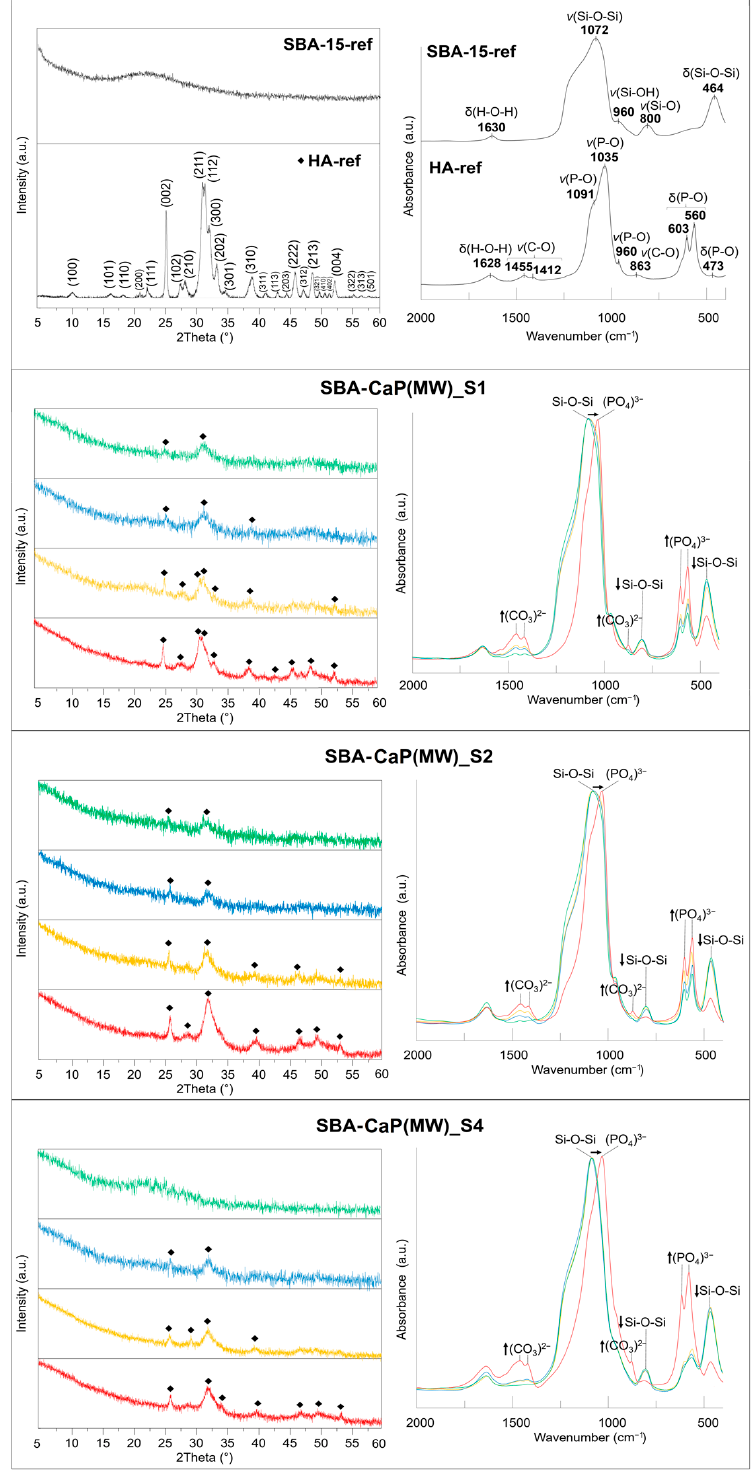
Figure 3. The XRD ( left ) and FTIR ( right ) results of selected SBA-CaP(MW) composites before ( green ) and after 7 ( blue ), 14 ( yellow ), and 21 ( red ) days of incubation in simulated body fluid together with SBA-15 and HA reference samples (types of vibration: ν —stretching, δ —bending).